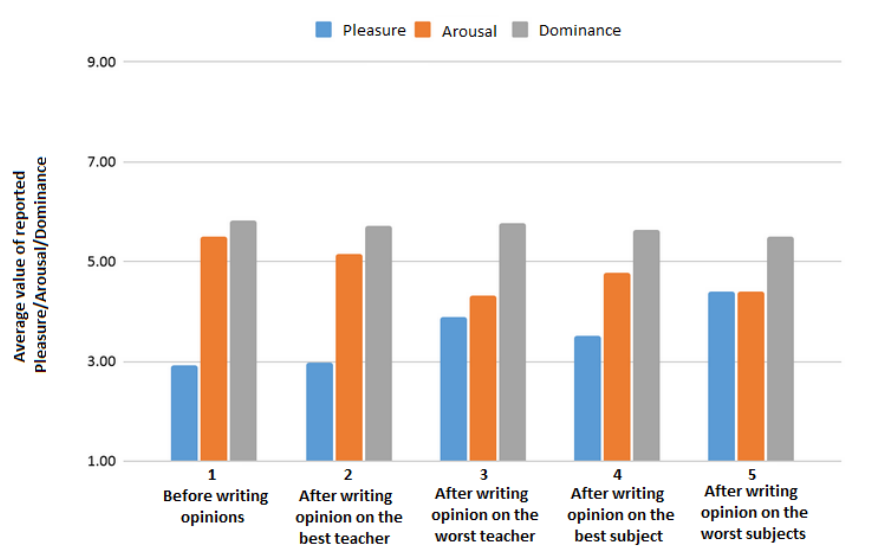
Figure 2. Average values of pleasure, arousal and dominance reported at different stages of the experiment session.